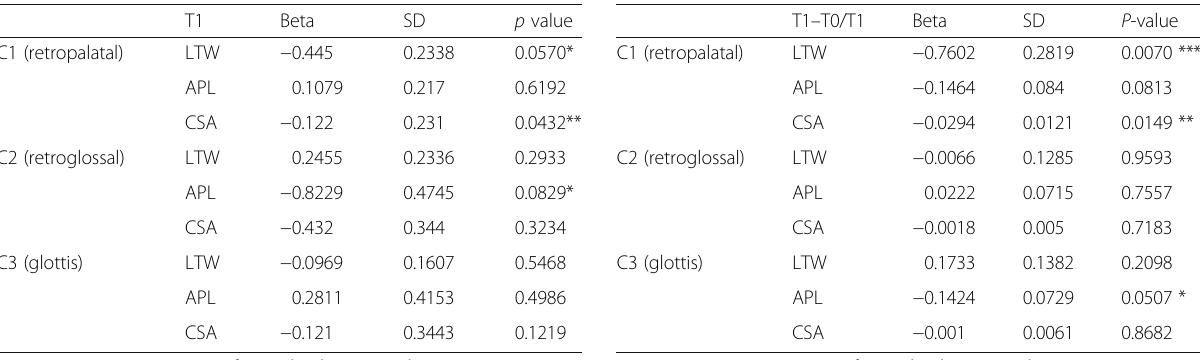
Table 3 Correlation between post-operative airway configuration and snoring